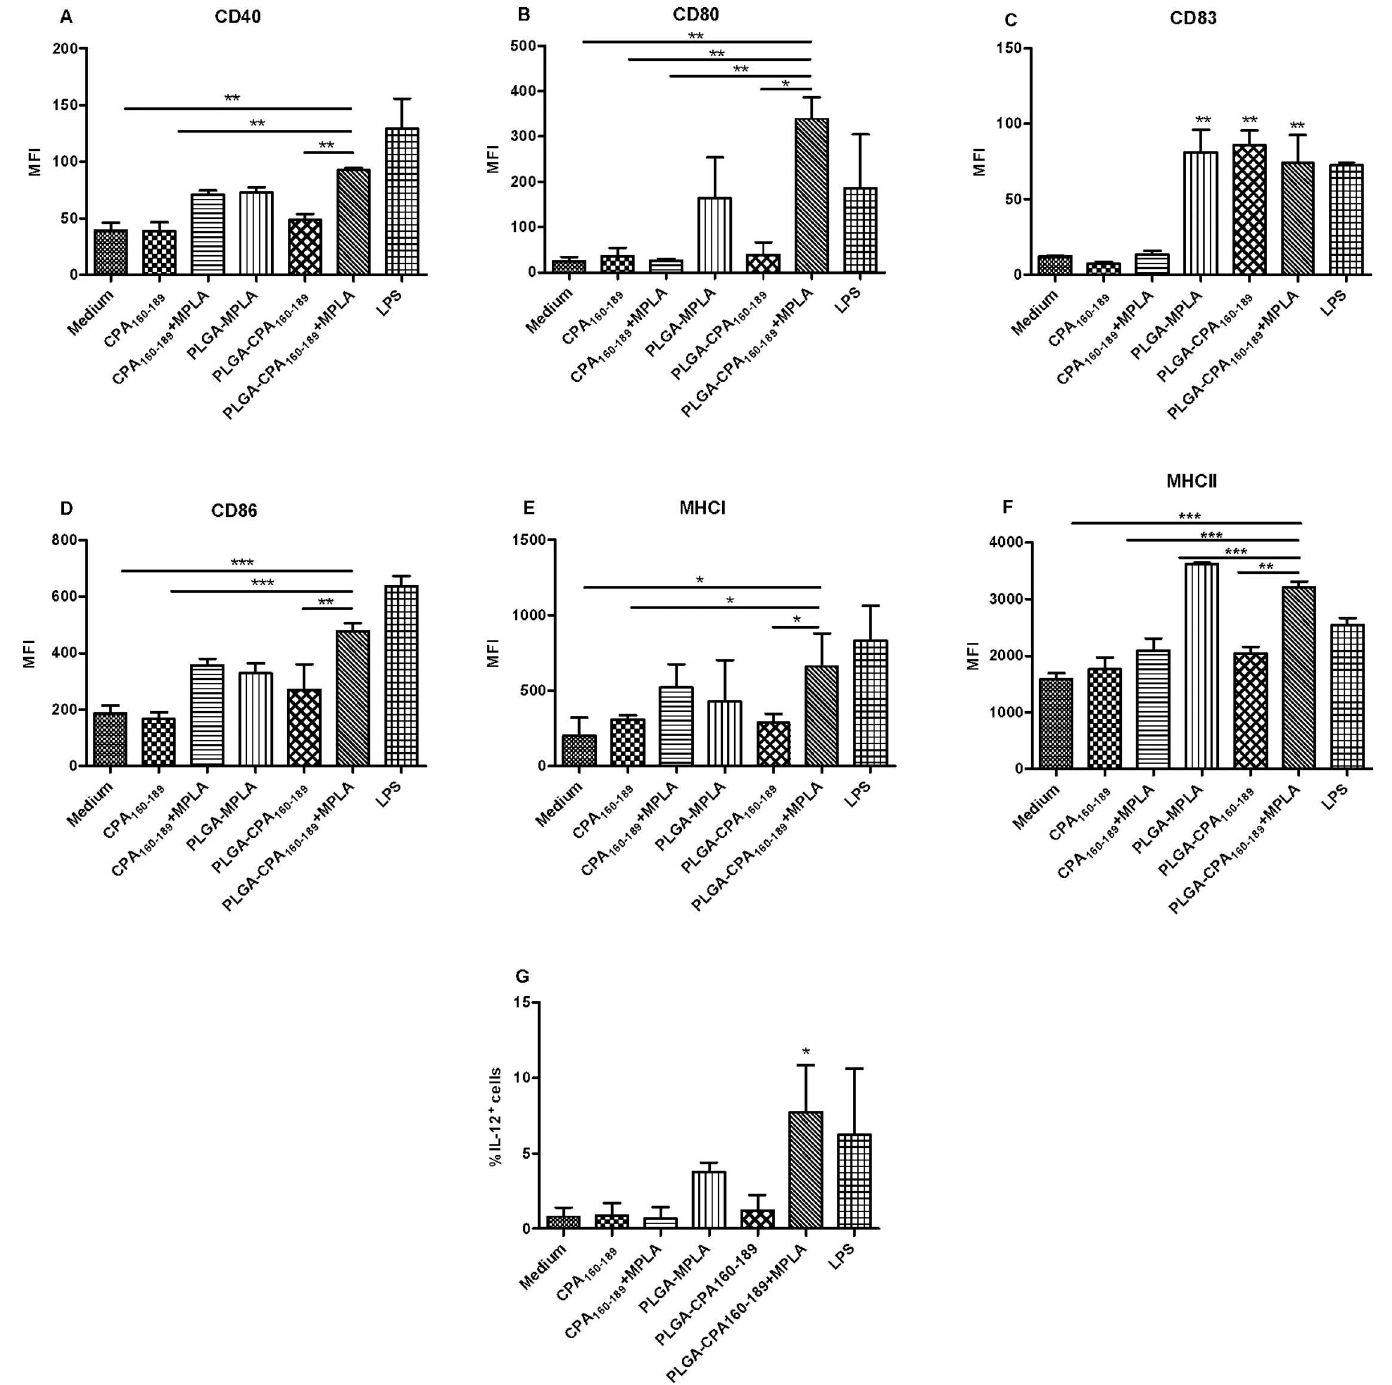
Fig 3. Co-encapsulation of CPA 160-189 and MPLA in PLGA NPs induced activation of DCs. (A-F) Diagramsshowingexpression(MFI values) of CD40, CD80, CD83, CD86, MHCI and MHCII moleculeson DCs and (G) (%) IL-12-producing DCs after pulsingwith PLGA NPs. Results are expressedas mean ± SD from three independentexperiments. * p < 0.05, ** p < 0.01, *** p < 0.001were assessedby one-wayANOVA and Tukey’s multiple